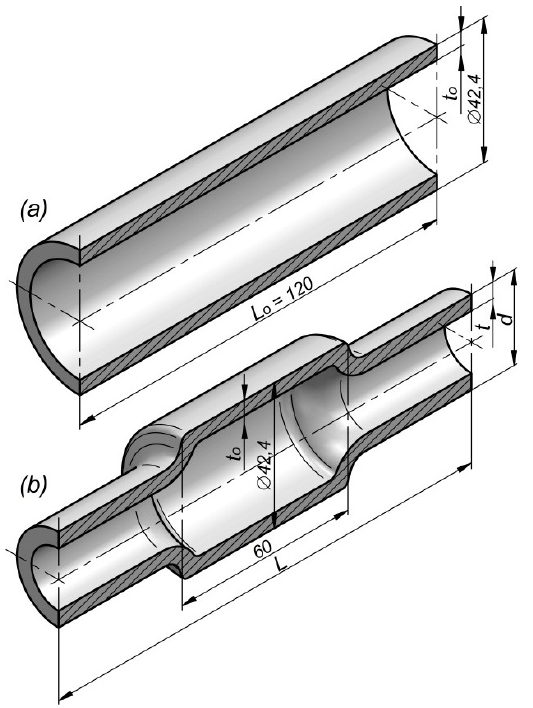
Figure 3. Shapes and dimensions of: ( a ) the compressed semi-finished tube, ( b ) compressed forging of the elementary hollow shaft.